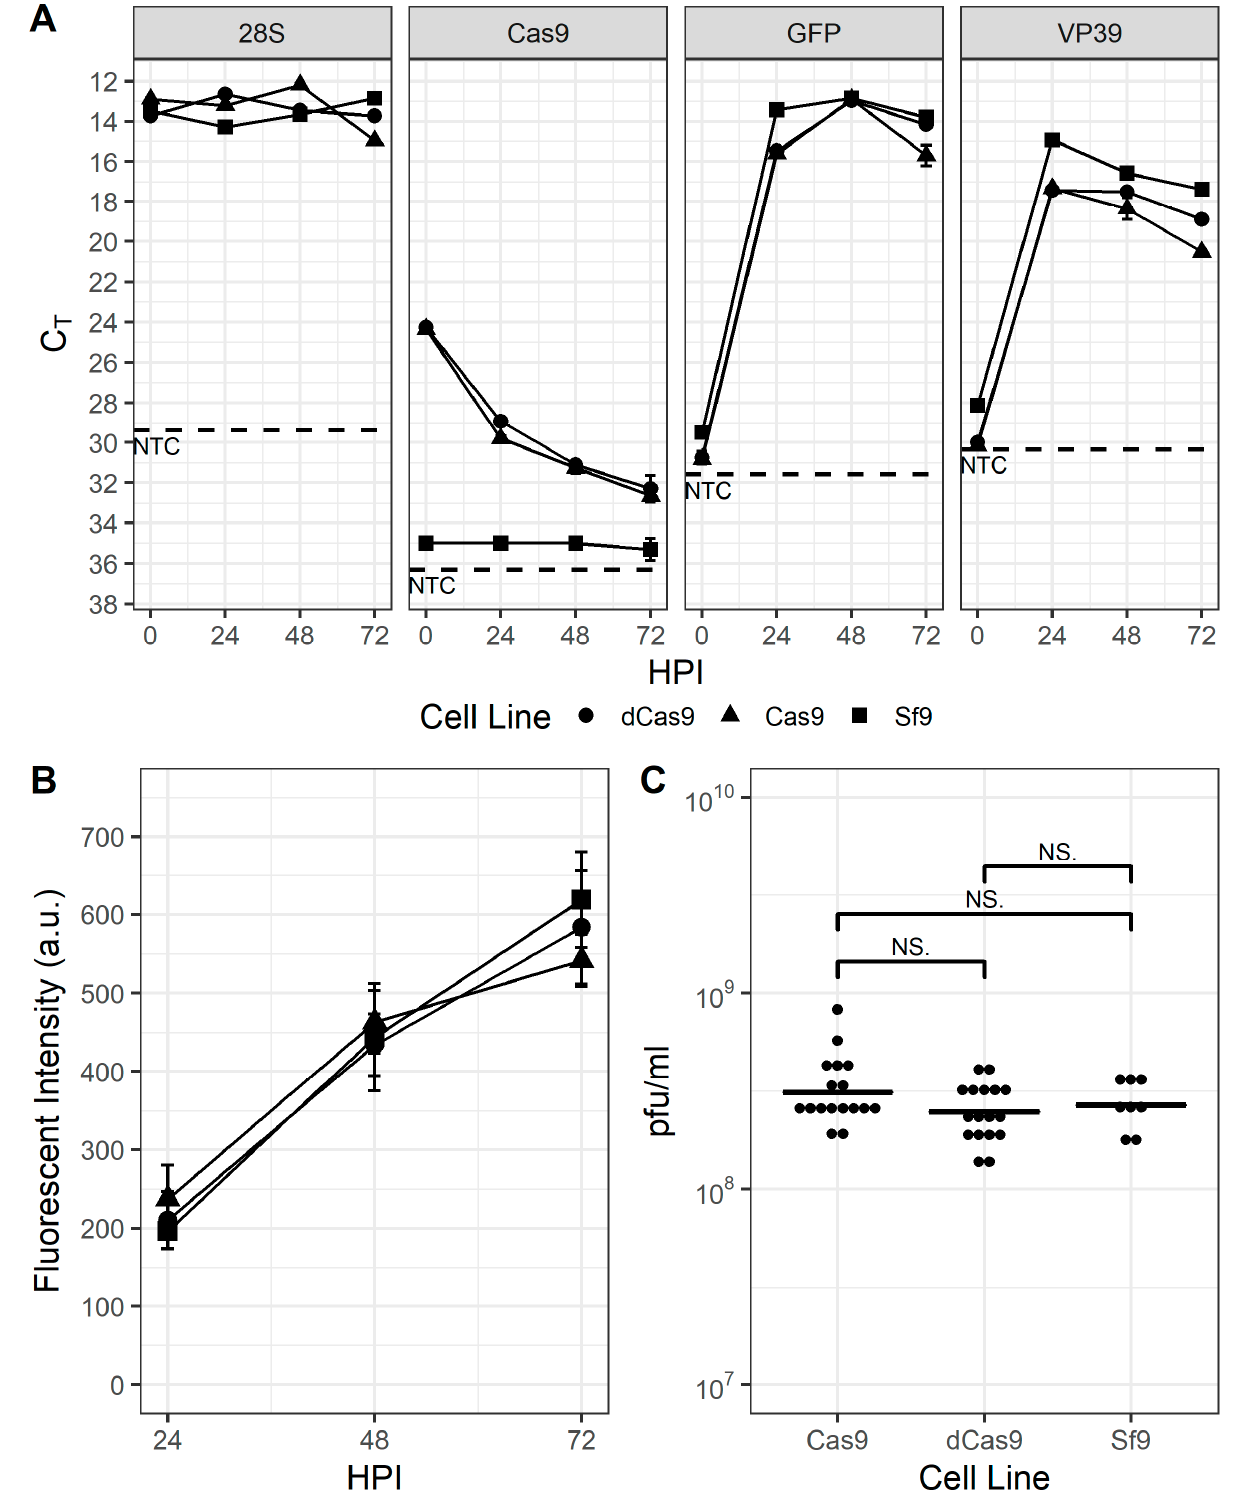
Figure 1. Sf9-Cas9 and Sf9-dCas9 cells are indistinguishable from the parental Sf9 cell line. ( A ). QPCR threshold cycle (C t )values of the Sf9-encoded 28S rRNA housekeeping gene, (d)cas9 gene, and virus-encoded vp39 and p6.9 promoter- expressed gfp reporter gene in baculovirus-infected Sf9 (squares), Sf9-Cas9 (circles), and Sf9-dCas9 (triangles) cells at 0, 24, 48, and 72 hpi. NTC: no template control ( B ). GFP fluorescence intensity of baculovirus-infected Sf9 (squares), Sf9-Cas9 (circles), and Sf9-dCas9 (triangles) cells at 24, 48, and 72 hpi and ( C ). infectious virus titer of supernatants from infected Sf9, Sf9-Cas9, and Sf9-dCas9 cells at 72 hpi. NS indicates non-significant differences in means according to Student’s t- test. 3.2. Evaluation of CRISPR-Mediated Repression and Disruption on GFP Production Initial experiments sought to establish transcriptional repression of the rBEV- encoded gfp gene. Individual rBEVs with sgRNAs targeting the template (GFP1 and GFP4) and nontemplate (GFP2 and GFP3) strands within the gfp ORF were constructed, and repression of gfp transcribed with immediate early (OpIE2), late (p6.9), and very late (p10) promoters was assessed. Sf9-dCas9 cells infected with rBEVs encoding nontemplate strand-targeting sgRNAs showed a marked decrease in the proportion of GFP-positive cells and fluorescence intensity compared to the control at 48 hpi for OpIE2-GFP (Figure S2A). For p6.9-GFP and p10-GFP, there appeared to be a slight (p6.9-GFP) or significant (p10-GFP) reduction in GFP-positive cells compared to the control at 24 hpi; however,